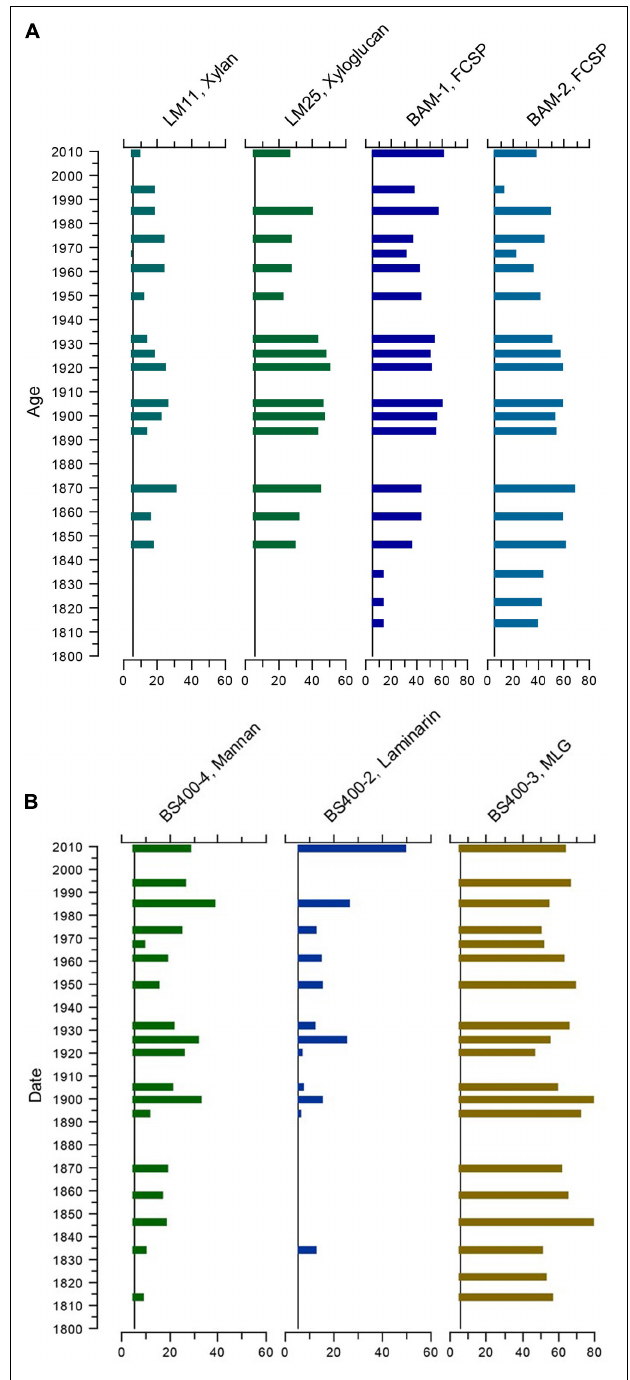
FIGURE 3 | Fluctuations in selected epitopes by age. (A) More or less synchronous temporal fluctuations in the epitopes, detected by the mAbs: LM11 (1 → 4)- β - D -xylan/arabinoxylan; LM25 xyloglucan; BAM1 FCSP (un-sulfated epitope present in sulfated fucan) and BAM2 FCSP (sulfated epitope present in sulfated fucan). FCSP, fucose-containing sulfated polysaccharides. (B) Changes in relative presence of epitopes by age, detected by the mAbs: BS-400-4 (1 → 4)- β - D -mannan; BS-400-2 callose, laminarin (1 → 3)- β - D -glucan, and BS-400-3 (1 → 3)(1 → 4)- β - D -glucan. MLG, mixed-linkage